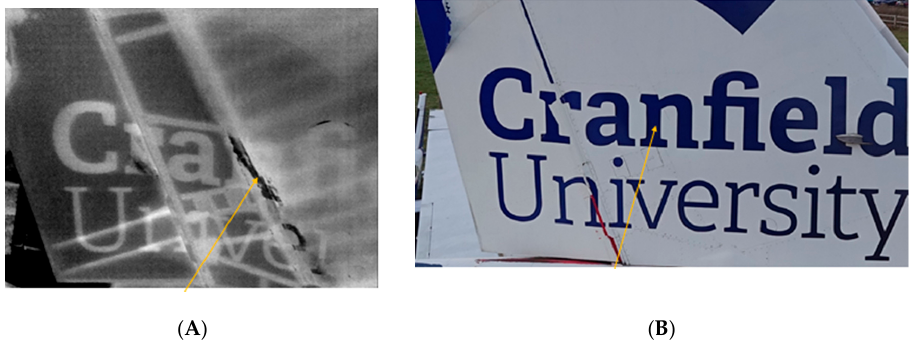
Figure 28. ( A ) Passive thermographic image of the tail/rudder of a Boeing 737. ( B ) Corresponding RGB image of the Boeing 737.